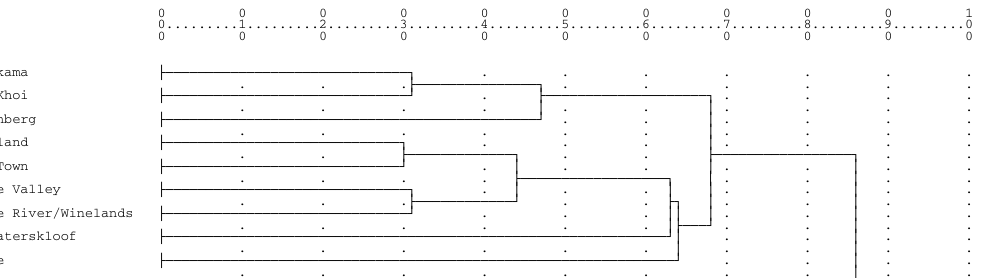
Figure 3 : Dendogram of last 8 regions in Western Cape Figure 3: Dendrogram of the last nine regions in the Western